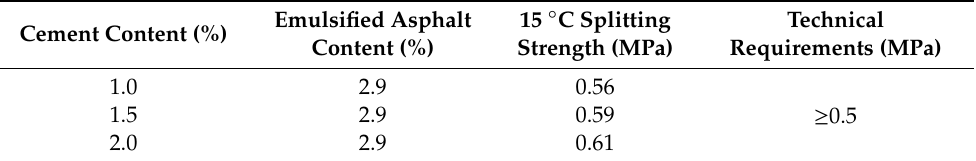
Table 4. Splitting test results of emulsified asphalt cold recycled mixtures.